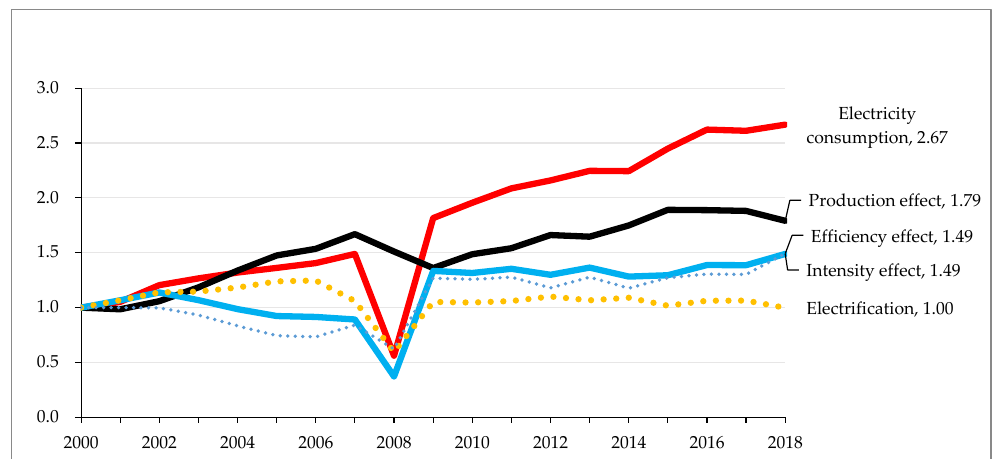
Figure A6. Basic metal electricity consumption LMDI results (fixed base year, multiplicative).